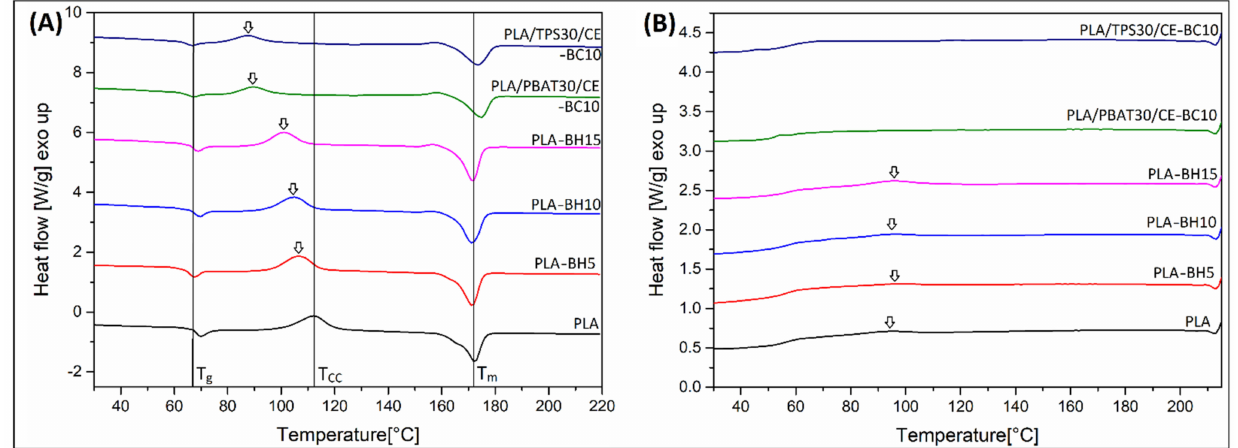
Figure 9. The DSC signal of FDM-printed BH composites. ( A ) First heating thermograms, ( B ) cooling